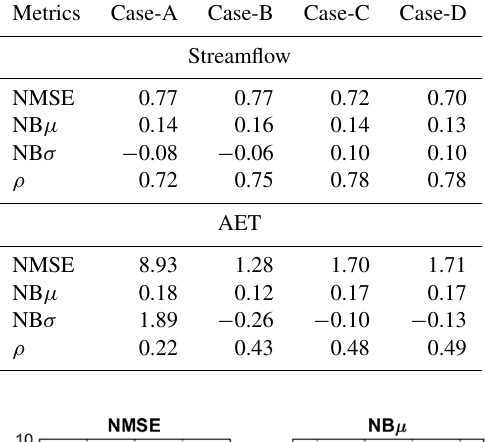
Table 6. Streamflow error statistics for calibration period, evalua- tion period, and total simulation period (in parentheses) for all four different cases in Stage-II Step-1 analysis.